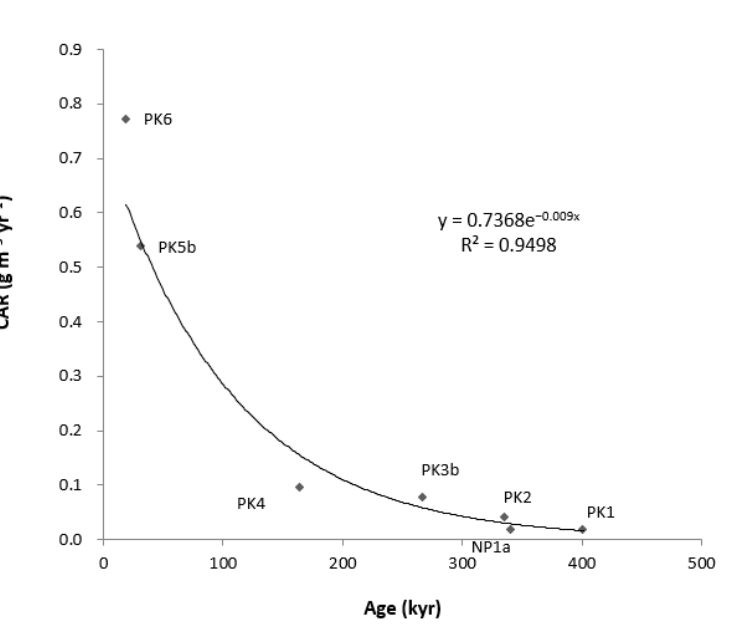
Figure 2. The Pakua tableland carbon accumulation rate (CAR) versus time for each pedon.